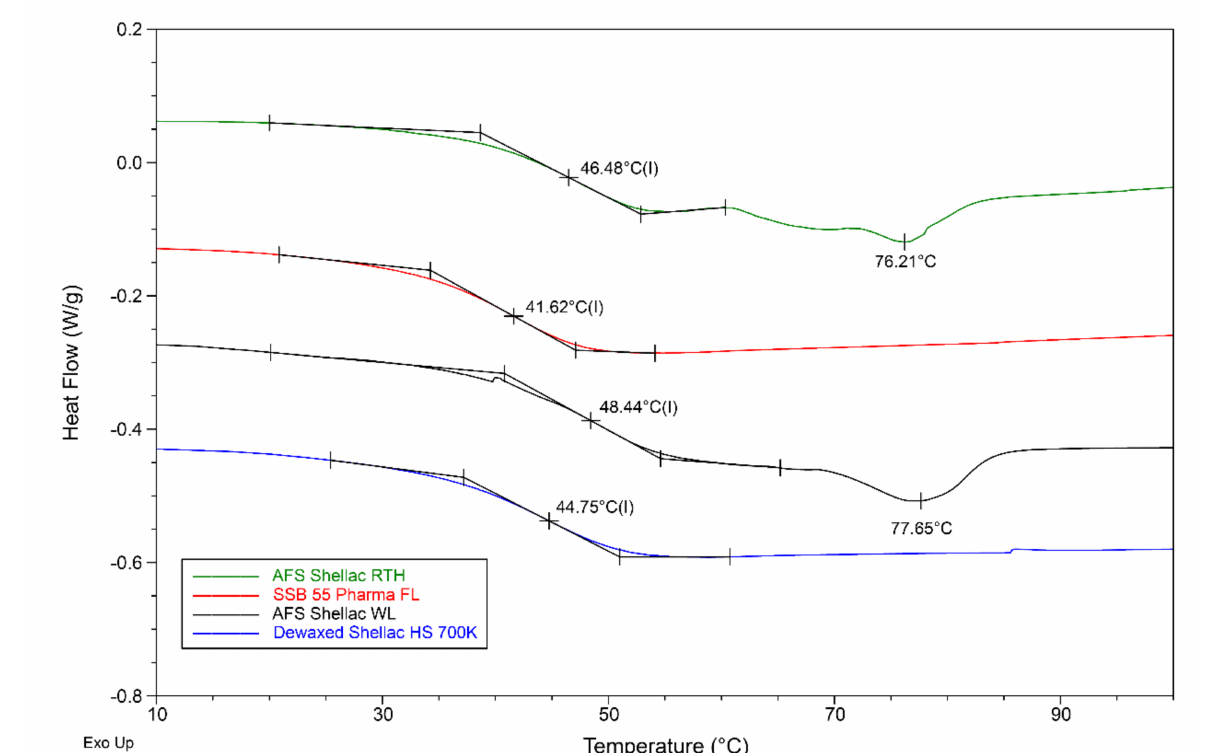
Figure 6. Overlaid DSC result of original shellac